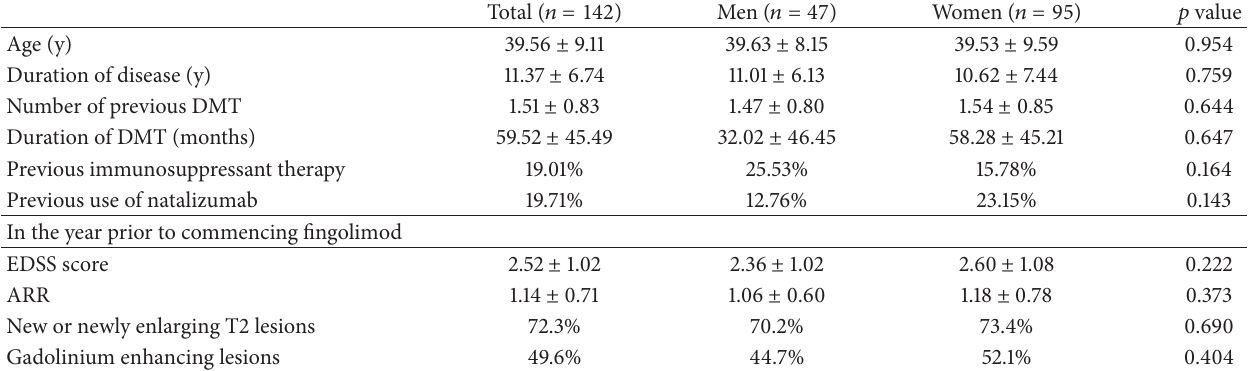
Table 1: Patient demographics and baseline clinical